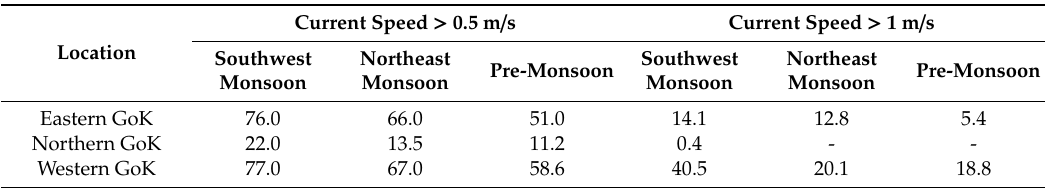
Table 2. Percentage of time when the current speed is more than 0.5 m / s and more than 1 m / s in di ff erent seasons at 3 selected locations.